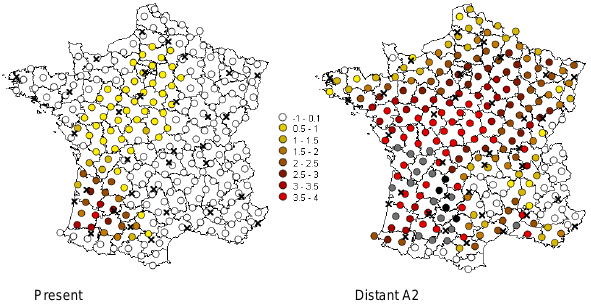
Present Distant A2 Figure 5. Indicator of risks for maize grain filling: di ff erence of number of years among 10 with at least once a maximum temper- ature higher than 38 ◦ C in the first half August, between the future (distant A2) and the present period, that is increase in the risk when positive values.